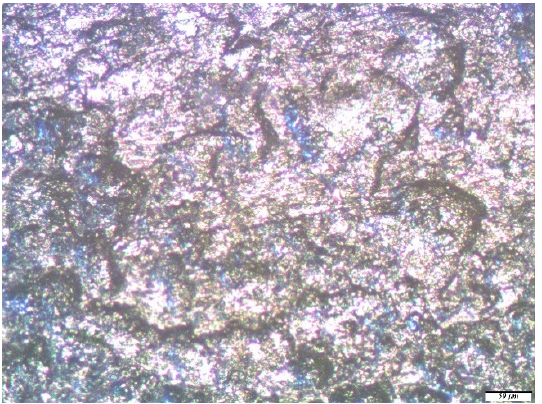
Figure 15. Micrograph of the surface area of a carbon steel sample, modified with solution of a mix- ture [1% VS + 1% AS], after conducting full-scale, one-year natural corrosion tests in an urban at- mosphere and removing the corrosion products.